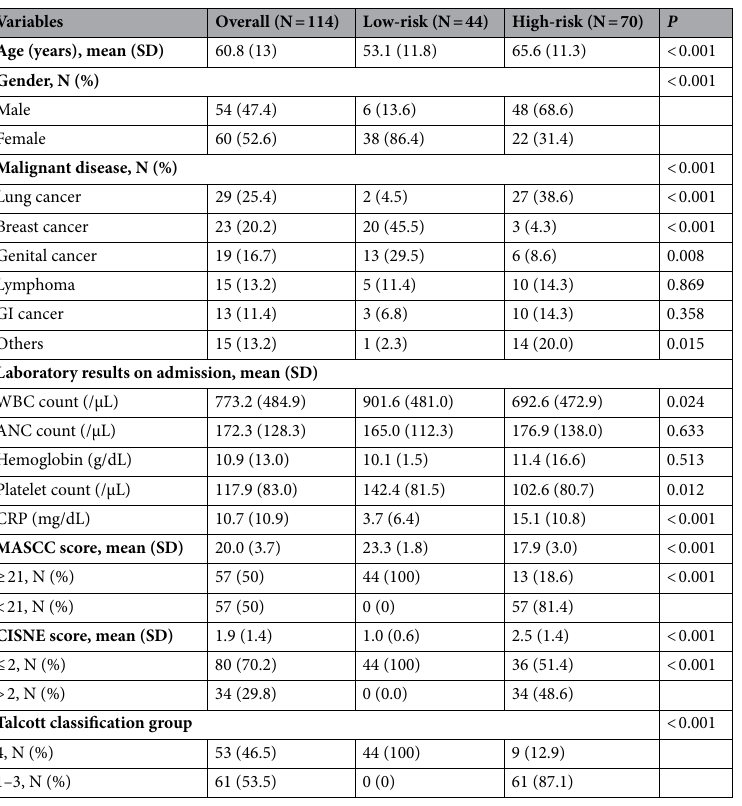
Table 1. Comparisons of demographic characteristics, laboratory findings, and risk scores between low- risk and high-risk groups. SD standard deviation, GI gastrointestinal, WBC white blood cell, ANC absolute neutrophil count, CRP C-reactive protein, MASCC Multinational Association of Supportive Care in Cancer, CISNE Clinical Index of Stable Febrile